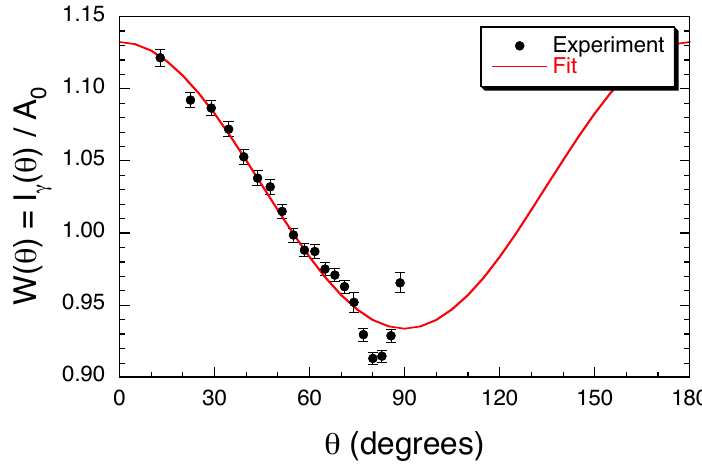
Figure 2. Measured angular distribution of prompt γ rays from 252 Cf(sf), depicted as black dots. The error bars correspond to statistical uncertainties only. The line represents the result of a fit according to Eq. 1. The obtained coe ffi cients are { A 2 / A 0 } = 0.13 ± 0.03 and { A 4 / A 0 } = - 0.0092 ± 0.0086, with A 0 = 0.930 ±